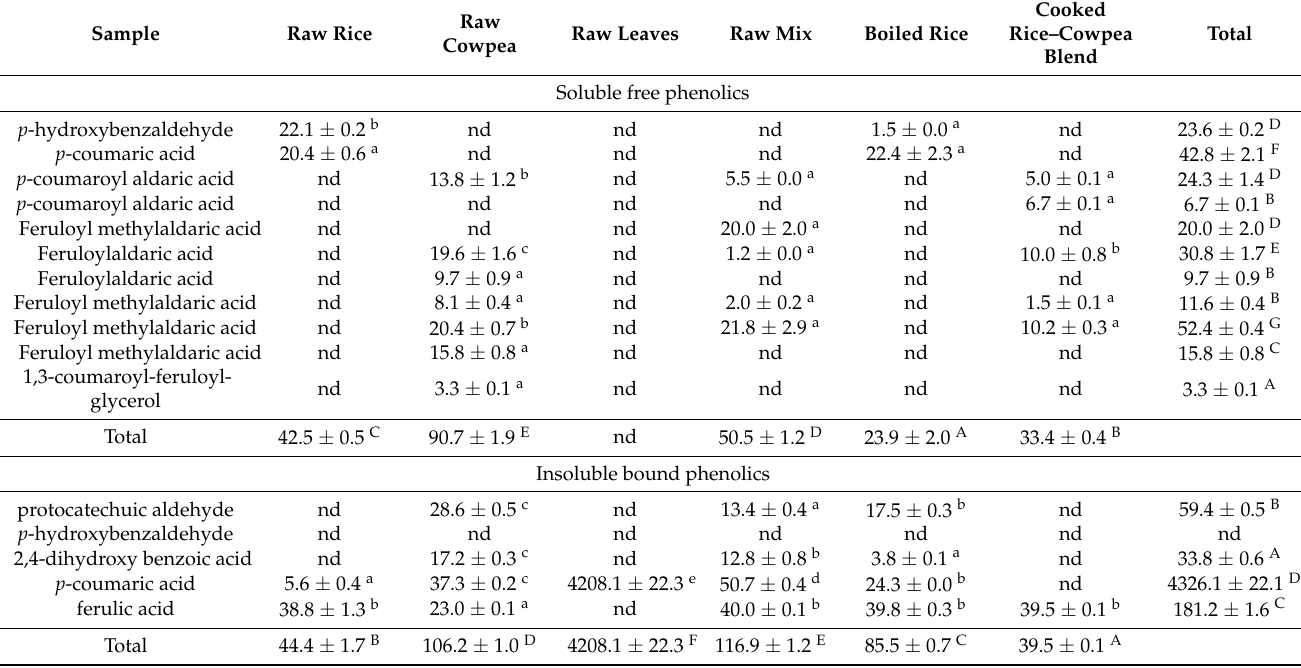
Table 2. Phenolic acid composition of raw white rice, cowpea, sorghum leaves, their composite blend, and cooked products.